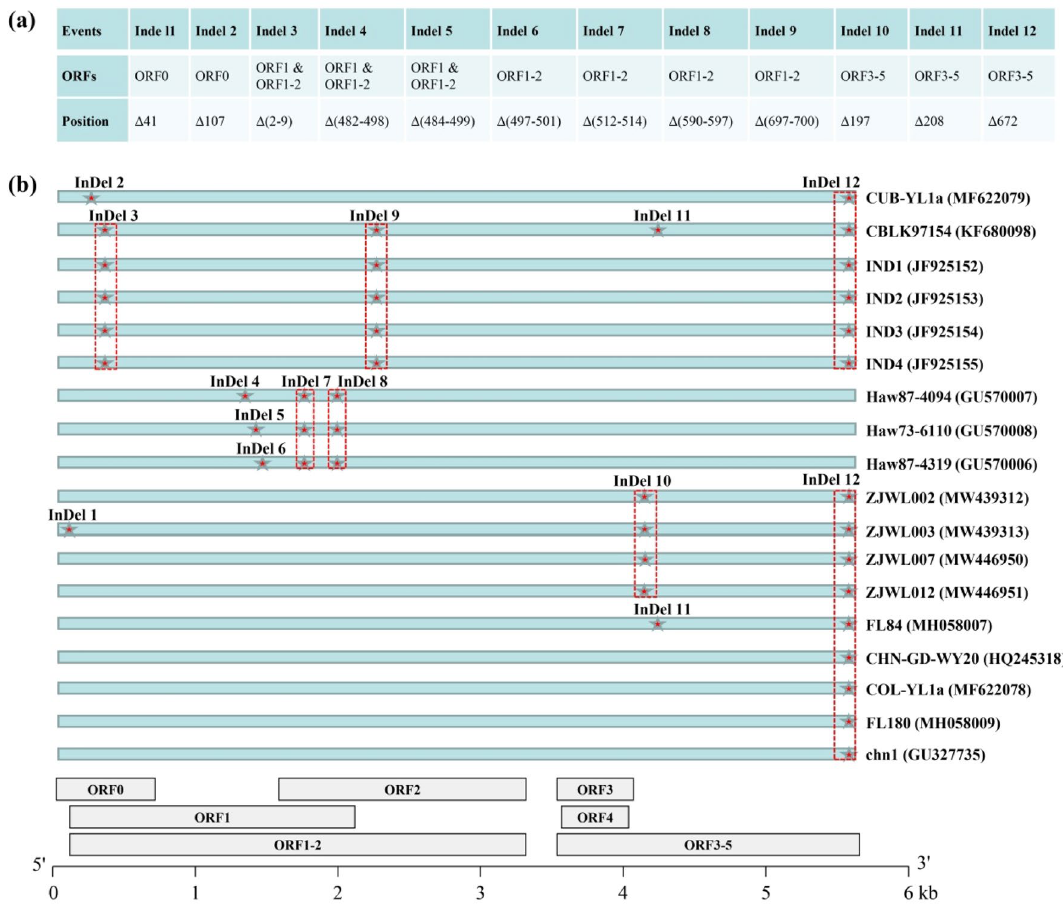
(filled star), and the same InDel event occurring among SCYLV isolates is shown by the red dotted line. All isolate sequences (from ORF 0 to 5) are indicated by blue